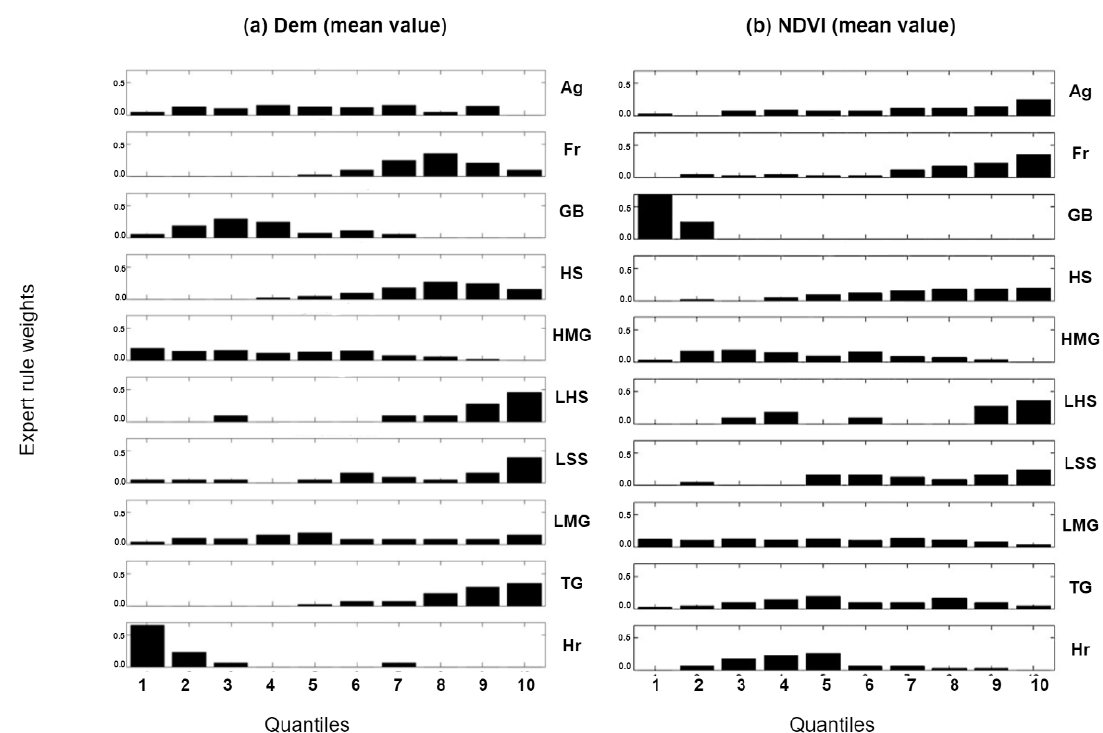
Figure 5. Example of expert rule weights for ancillary data. Y-axis shows the initial conditional probability, and the X-axis shows the 10 quantiles.